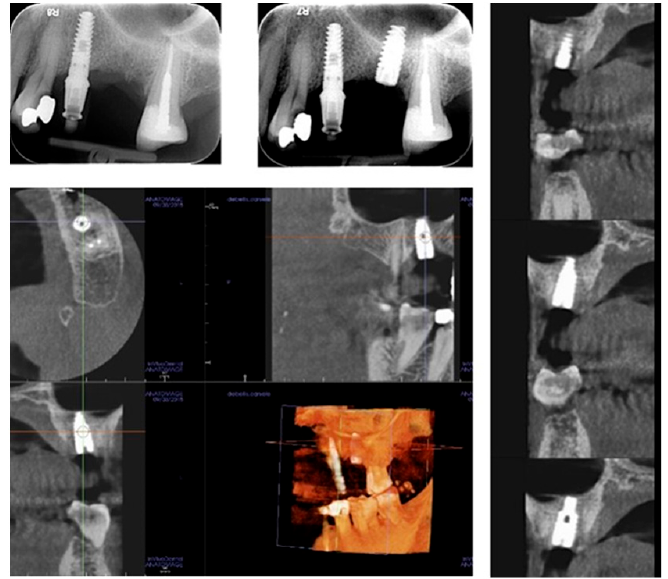
Figure 5. Radiological investigations showing the pre ‐ surgical planning of the crestal sinus lifting and the radiological result after implant insertion; the elevation of sinus membrane is evident, and no signs of intra ‐ sinusal inflammation are detectable after surgery.